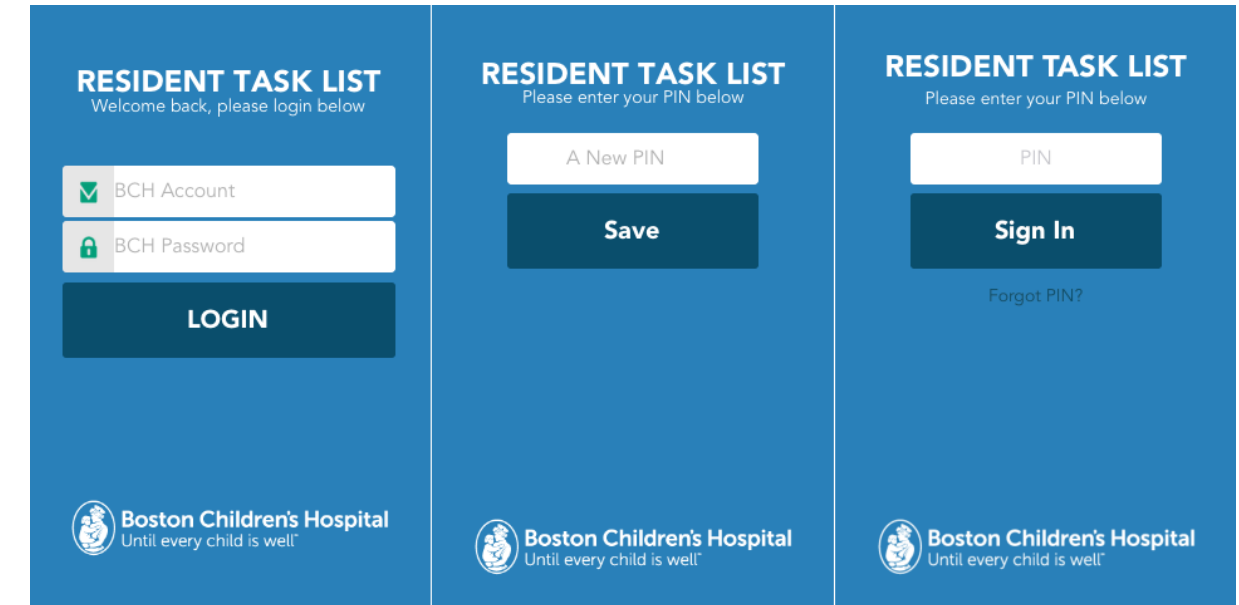
Figure 1. TaskList enterprise authentication and